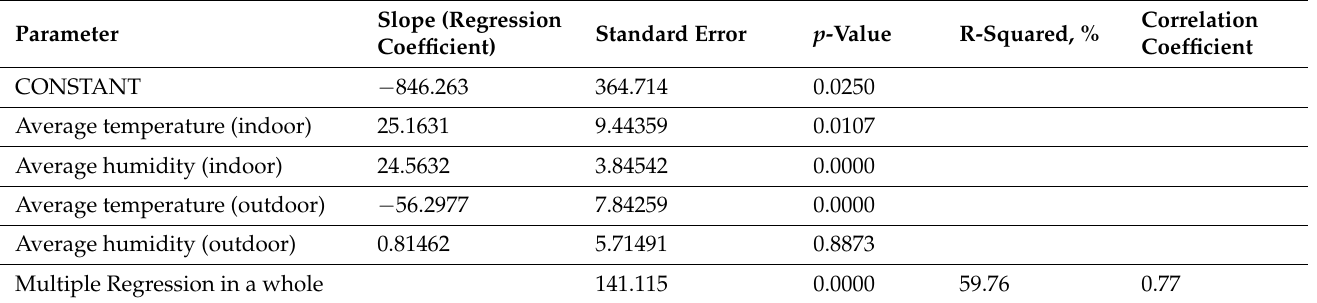
Table 4. Multiple regression parameters of radon concentration on all meteorological